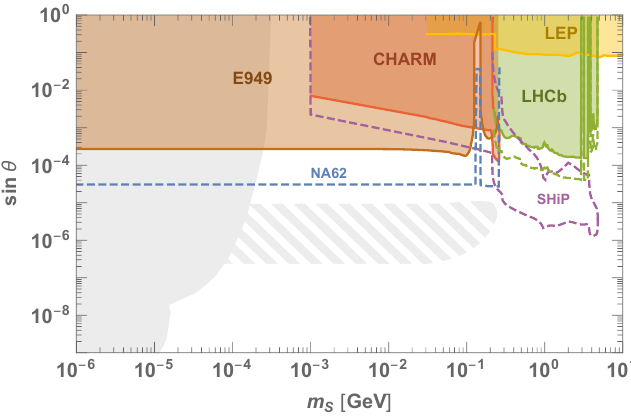
Figure 3 . Current limits (solid lines) and projected sensitivities (dashed lines) from accelerator and beam dump searches for new light scalars S decaying visibly into standard model particles according to eq. (2.3). See text for more details and references. For comparison, we also indicate the astrophysical constraints discussed in section 5.4 (grey